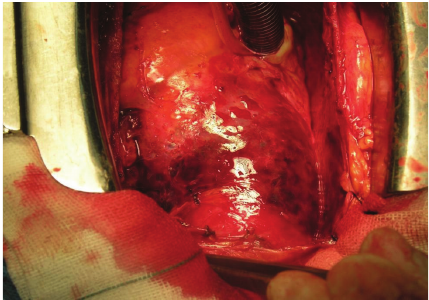
Figure 2: Ascending aortic